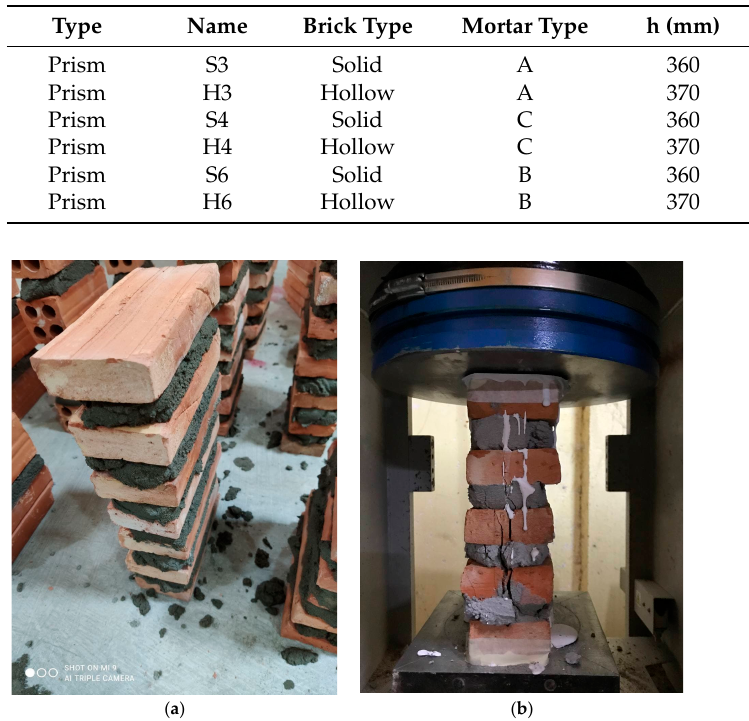
Figure 3. ( a ) Solid brick prism; ( b ) Prism failure.